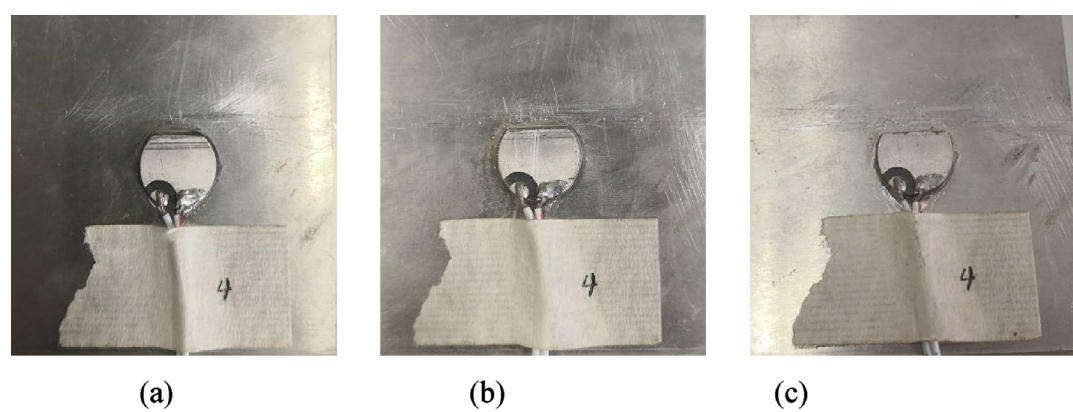
Figure 7. Breakage of 4# PZT: ( a ) 10% breakage; ( b ) 20% breakage; ( c ) 30%